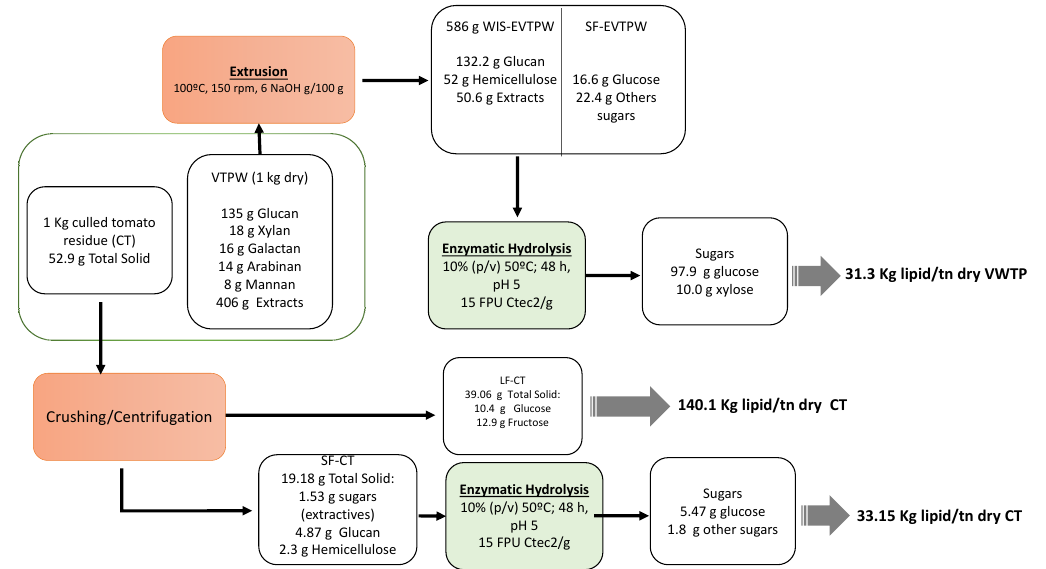
Figure 4. Sugar mass balance from organic residues from tomato greenhouse crops. VTPW: vegetal tomato plant waste; WIS-EVTPW: Water insoluble solid from extru- date vegetal tomato plant waste; SF-EVTP: soluble fraction from extrudate vegetal tomato